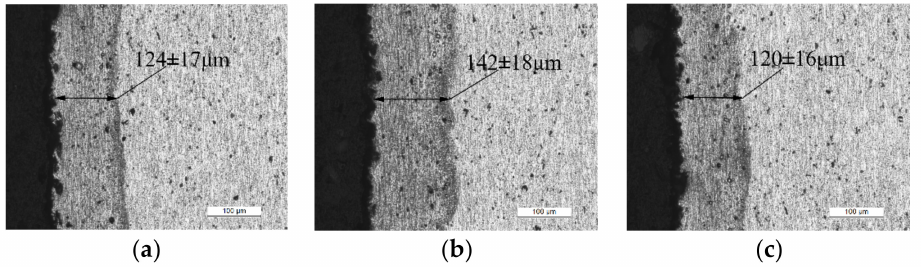
Figure 10. Profile of Al-alloy by optical